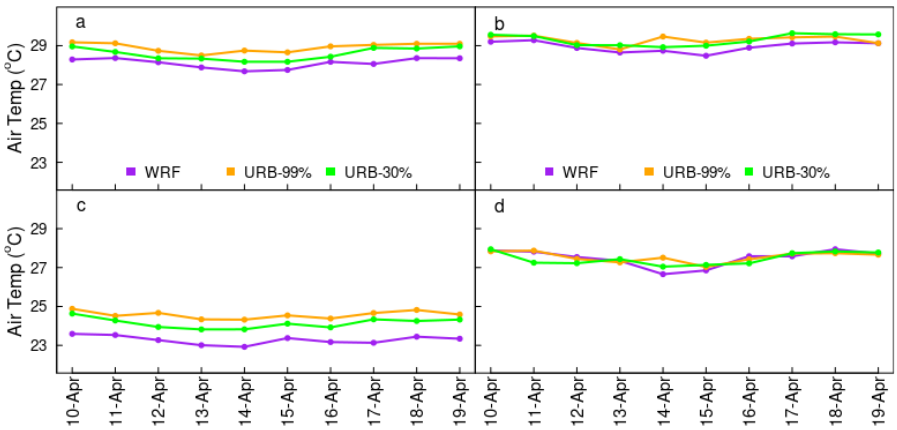
Figure 8. Daily mean near-surface (2 m) air temperature for current LULC, high-urbanization (URB_99%), and low-urbanization (URB_30%) scenarios at ( a ) Dar, ( b ) Dar-Port, ( c ) Morogoro, and ( d ) Kibaha stations. Table 5. Daily mean near surface air temperature difference (°C) for urbanization scenarios from the current LULC at four stations.